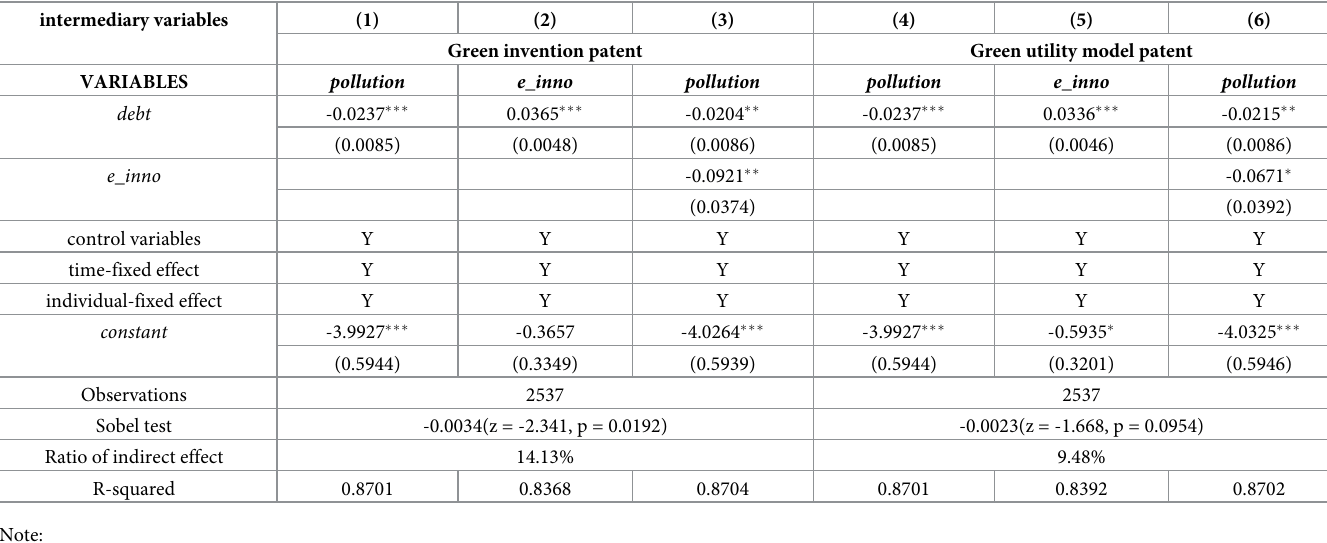
Table 7. Mediation effect